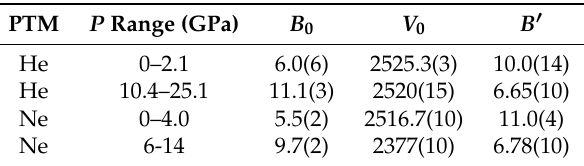
Table 1. The bulk modulus ( B 0 ) and its derivative ( B (cid:48) ), and the zero volume pressure ( V 0 ) parameters obtained from the third-order Vinet equation of state. Please note that the errors for the high-pressure ranges are only based on two parameters refining at one time, and the highest errors of the two combinations were